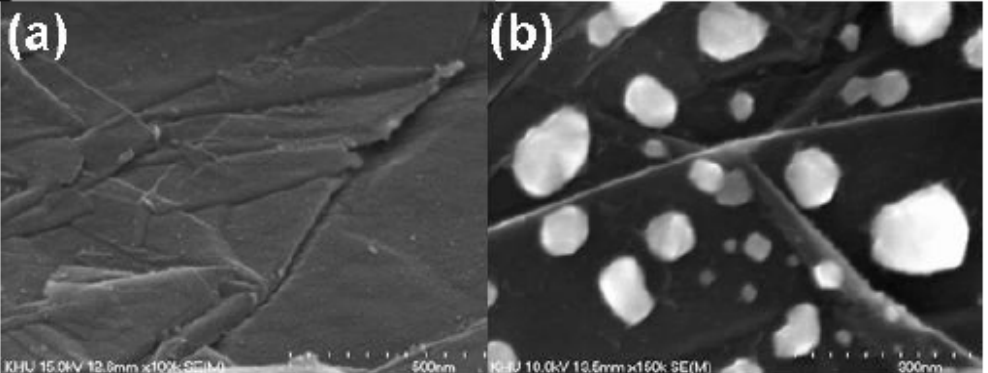
Figure 20. SEM images of ( a ) bare graphite foil substrate and ( b ) after Ni film deposition and agglomeration of catalyst nanoparticles during the annealing process, reported from [48].